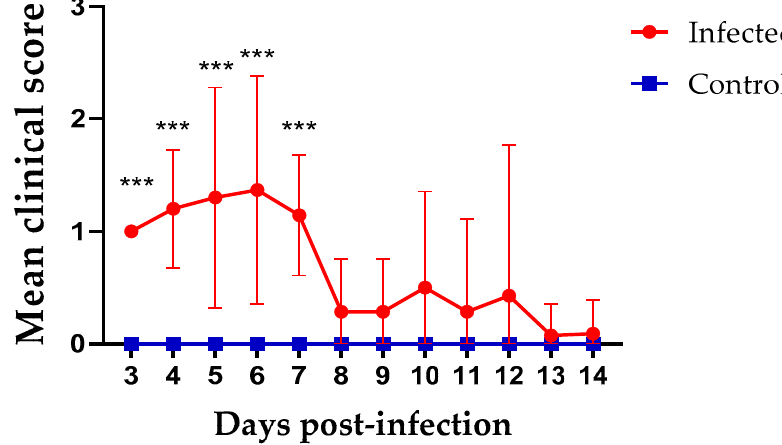
Figure 1. Mean clinical scores for infected and control groups starting from 3 to 14 dpi following infection at 1-day of age. The daily mean clinical scores were compared using Mixed-effects model followed by Sidak’s multiple comparisons test, and the error bars represent the standard deviation (SD). Statistical significance: *** p < 0.001.